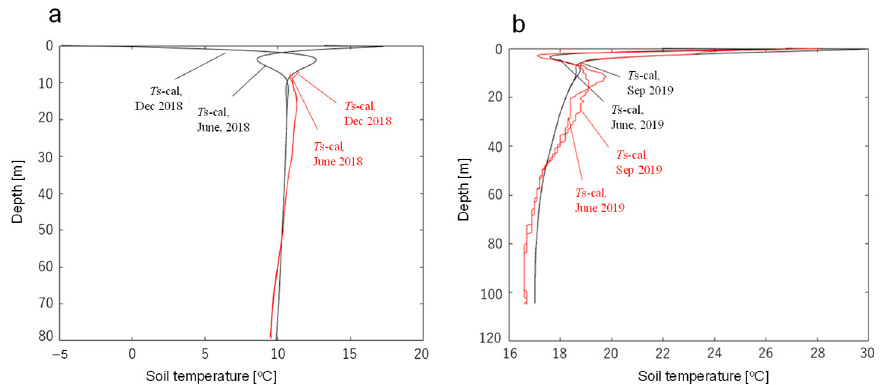
Figure 6. Mesh design of the heat transfer simulation for ( a ) Sapporo and ( b ) Tokyo.